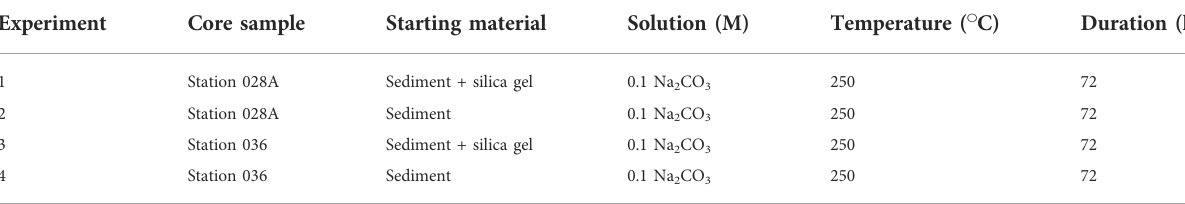
TABLE 1 Experimental conditions for the hydrothermal reactions.